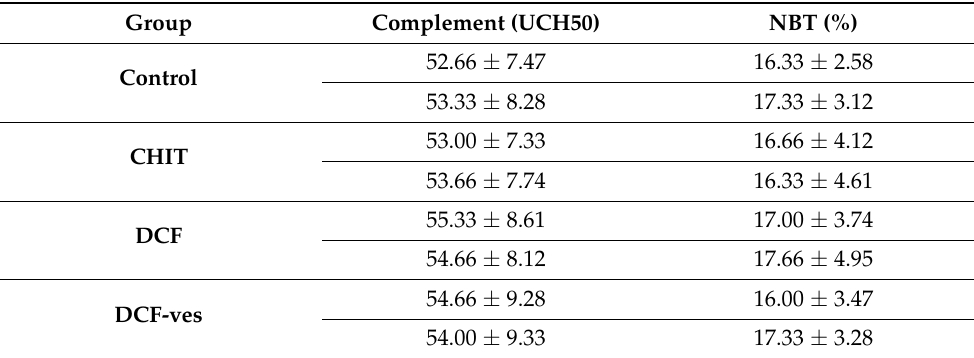
Table 7. Serum complement levels and phagocytic capacity of peripheral neutrophils in CHIT, DCF and DCF-ves groups. Values are expressed as the arithmetic mean ± S.D. of the average values for 6 animals per